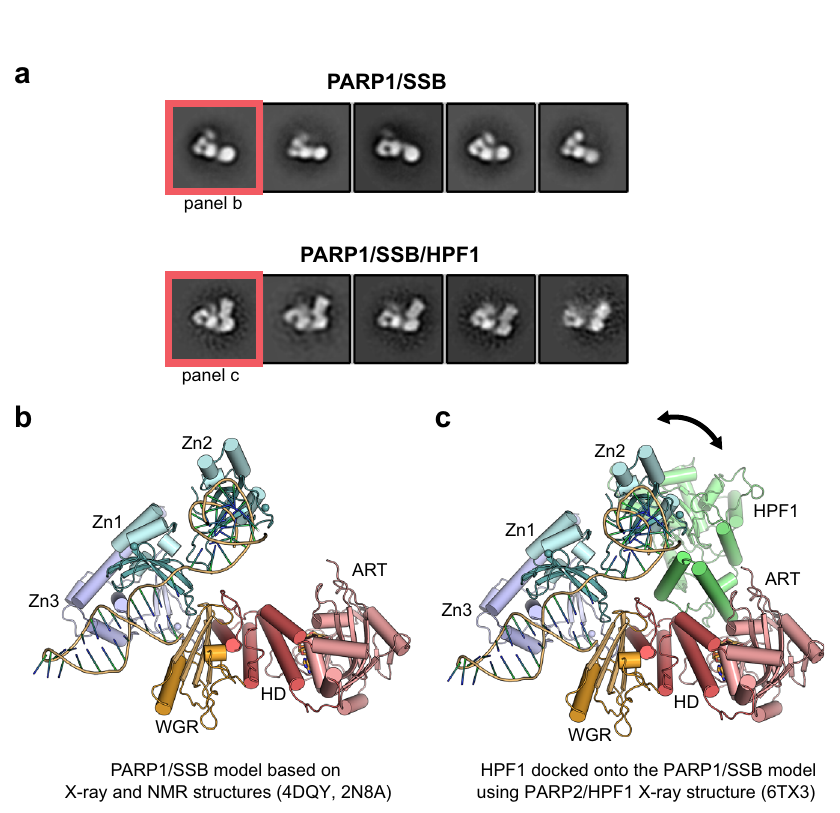
Fig. 7 Architecture of the HPF1 complex with full-length PARP1 bound to a DNA break. The PARP1/DNA SSB complex was analyzed by negative-stain electron microscopy in the absence and presence of HPF1. a 2D class averages provided views of the complexes without and with HPF1 that could be interpreted with the aid of published structures of PARP1 domains (Zn1, Zn2, Zn3, WGR, and CAT (HD/ART)) on DNA as shown in b and c . b A combined model of a PARP1 Zn1/Zn3/WGR-CAT/DNA structure (4DQY) aligned to a PARP1 Zn1/Zn2/DNA NMR structure (2N8A) c Same as in b with HPF1 added based on the structure of PARP2 CAT Δ HD/HPF1 (6TX3) 43 . The 2D averages did not suggest a location for the BRCT domain, which we infer to remain fl exibly tethered to the rest of the complex. Consistent with our interpretation of PARP1 domains, the addition of HPF1 adds to the globular end of the protein interpreted as the ART (panel c ). The orientation of HPF1 with respect to the catalytic domain remains relatively fi xed, whereas the orientation of HPF1 relative to the PARP1 regulatory domains appears to adopt two different conformations, highlighted by the arrow in panel c